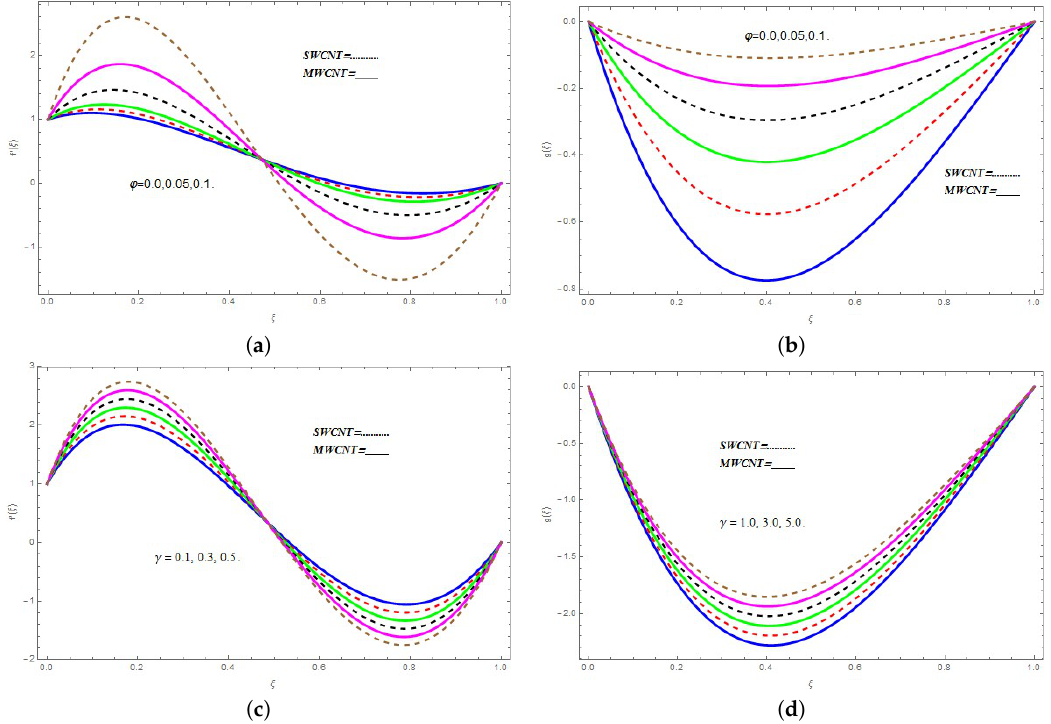
Figure 2. ( a ) Variation in f (cid:48) ( ξ ) with different values of ϕ ; ( b ) Variation in g ( ξ ) with different values of ϕ ; ( c ) Impact of γ on f (cid:48) ( ξ ) ; ( d ) Impact of γ on g ( ξ )